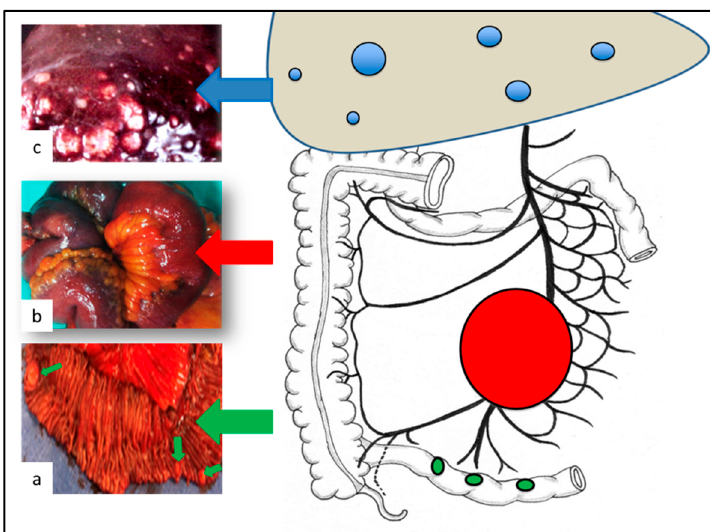
Figure 1. Classical presentation of small-intestinal neuroendocrine tumors (SI-NETs). ( a ) Small primary tumors (<20 mm), distal in the ileum, and multiple in 30% to 50% of cases; ( b ) Mesenteric lymph node metastases present in more than 80% of cases at diagnosis, typically larger than primary tumors; ( c ) Liver metastases present in approximately 50% of cases at diagnosis usually multiple and bilobar.